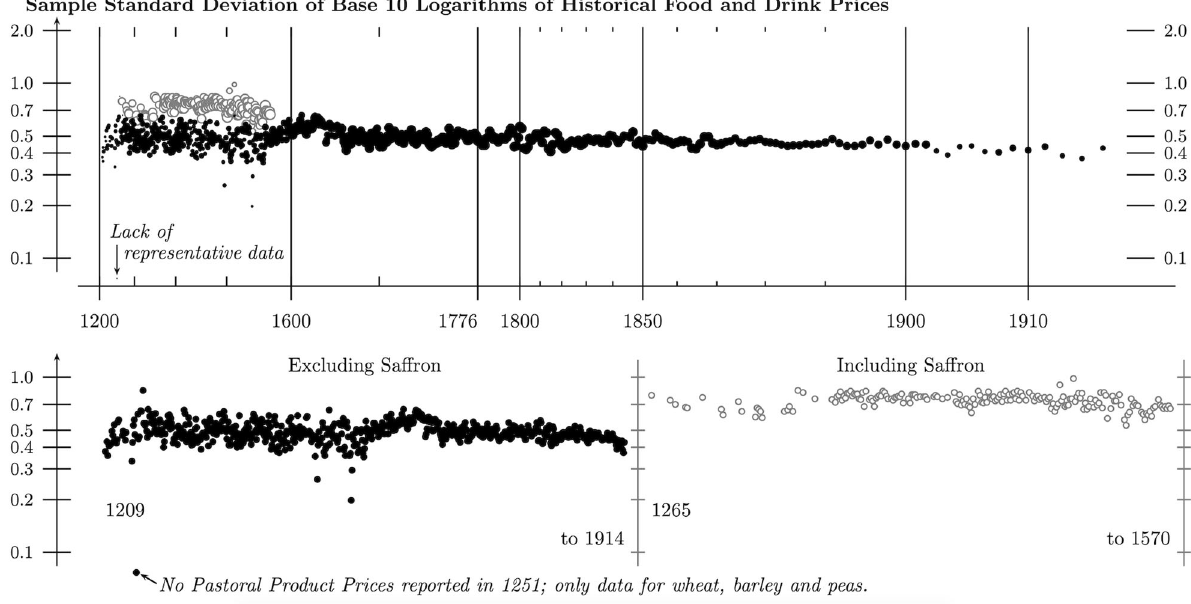
Fig. 3 Log price distribution widths for a long-term time series. Raw estimates of the width of the distribution of log prices using data from a single time series for England (Clark, 2004) covering seven hundred years. In the upper panel, the sizes of data points correspond to the number of items for which prices are reported for the corresponding dates. Dates for which no saffron price was reported are shown as fi lled black discs. Where the price of saffron was reported, the width of the distributions including the saffron are shown as un fi lled circles, and the width of the same distributions but excluding saffron are shown as fi lled black discs. HUMANITIES AND SOCIAL SCIENCES COMMUNICATIONS| (2022) 9:170